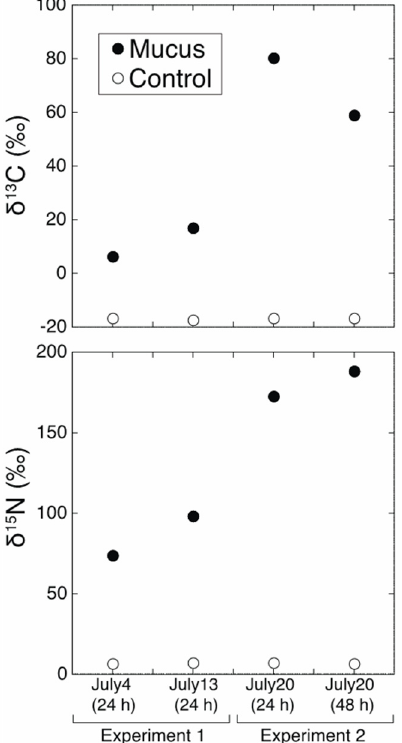
Figure 1. δ 13 C and δ 15 N signatures of COTS larvae after 24 h or 48 h of incubation with δ 13 C- and δ 15 N-labeled coral mucus and under control conditions. Closed and opened circles indicate fed larvae (with mucus) and unfed larvae (without mucus), respectively. Dates indicate the day of fertilization. Each plot comes from a single analysis.